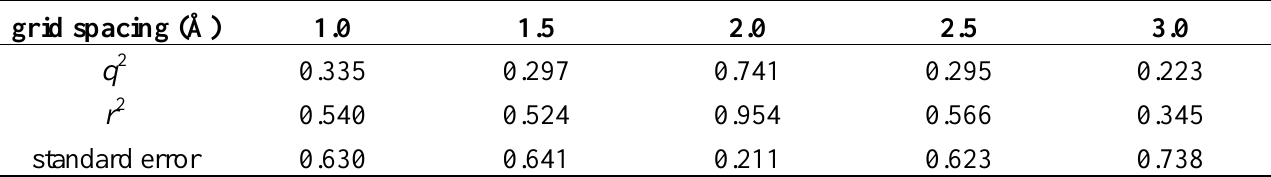
Table 2. Influence of Different Grids on the CoMFA